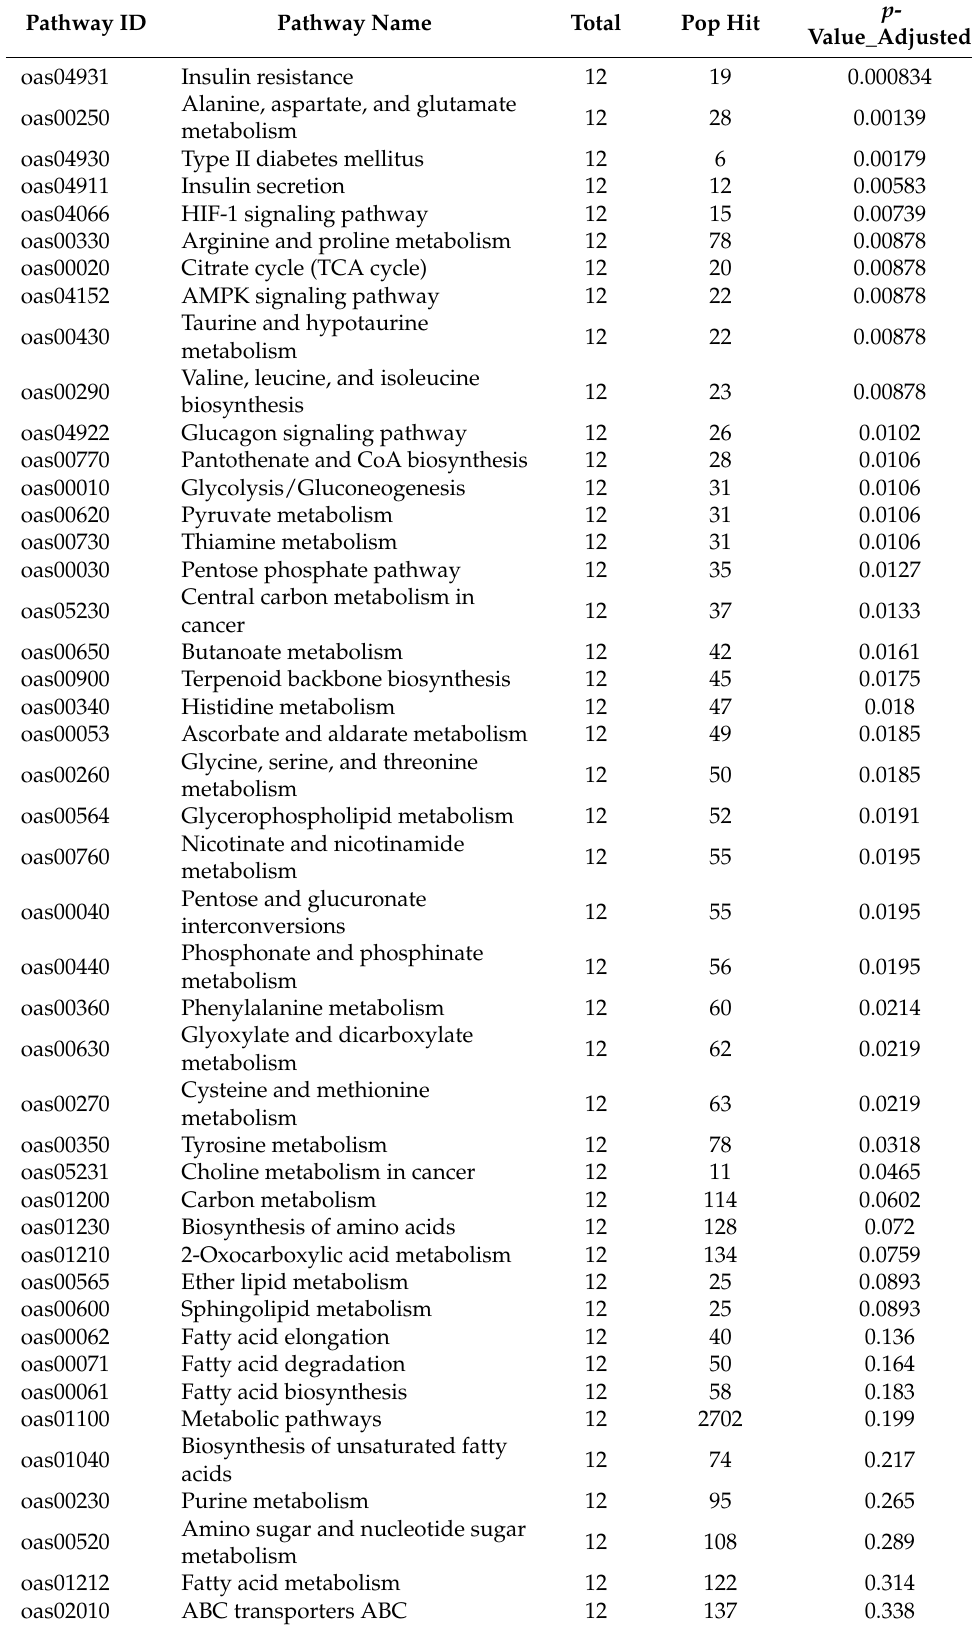
Table 1. Metabolic pathways of candidate biomarkers in the goat liver related to Cd